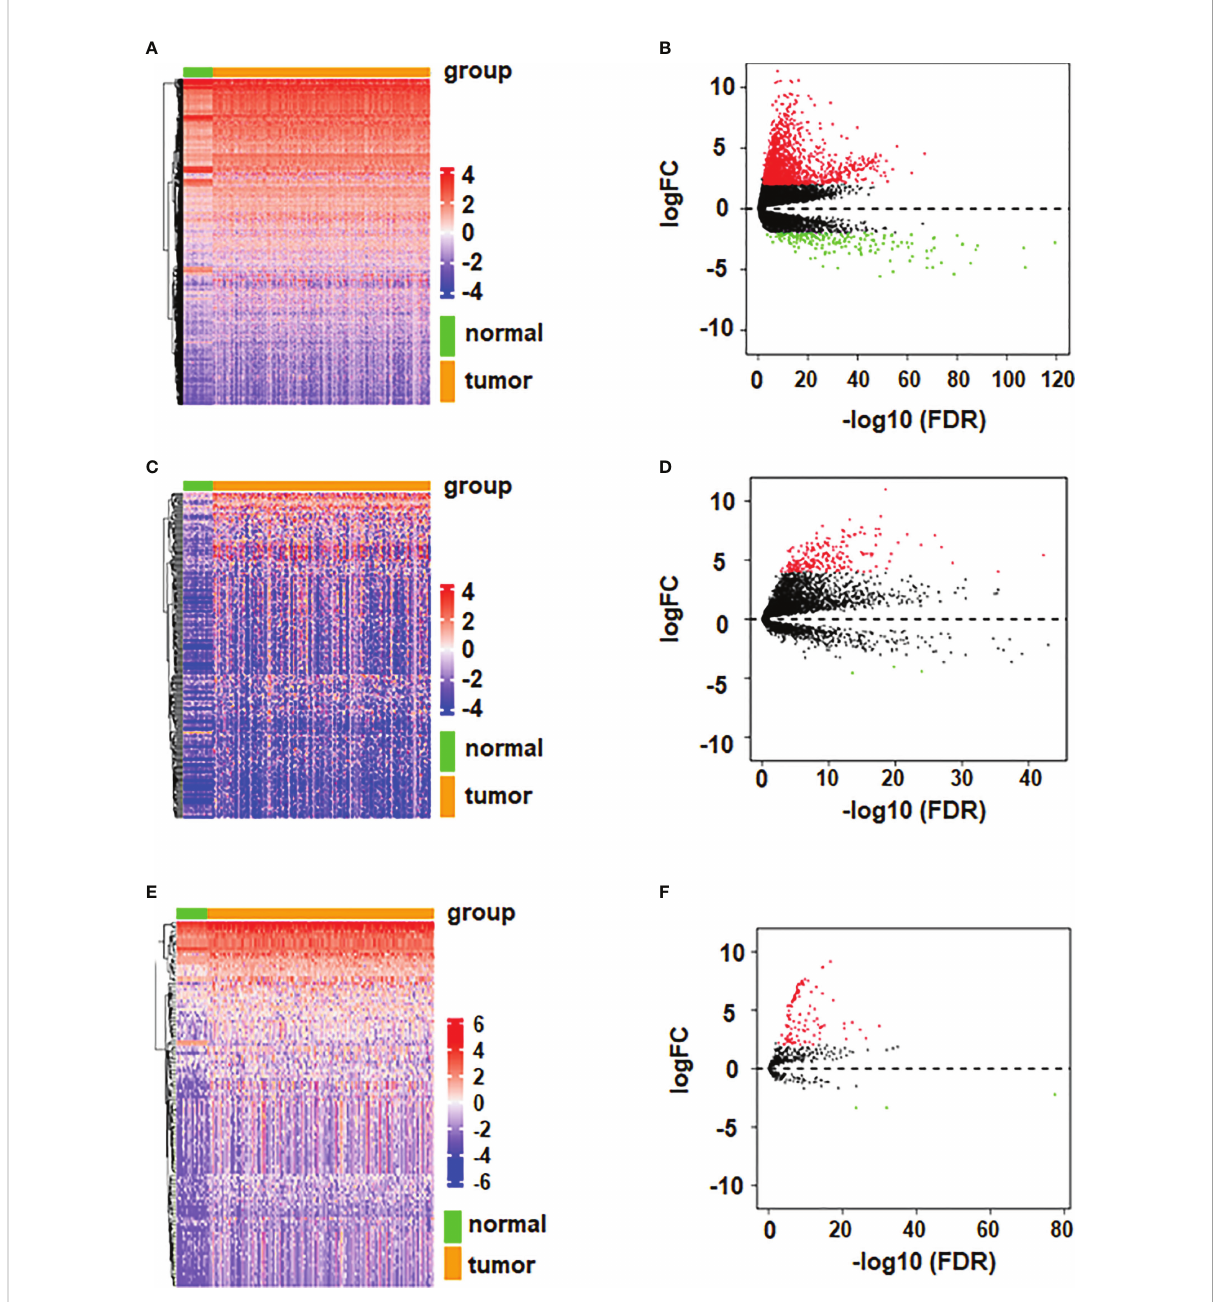
FIGURE 1 Volcano plots and heatmaps of differentially expressed mRNA, miRNA, and lncRNA. (A) Volcano plot of differentially expressed mRNA. (B) Heatmap of differentially expressed mRNA. (C) Volcano plot of differentially expressed lncRNA. (D) Heatmap of differentially expressed lncRNA. (E) Volcano plot of differentially expressed miRNA. (F) Heatmap of differentially expressed